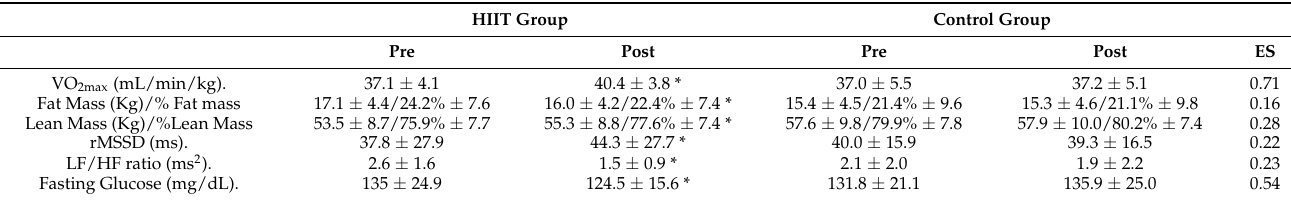
Table 1. Variables analysis before high-intensity interval training (HIIT) intervention and following training period in both groups. HIIT Group Control Group Pre Post Pre Post ES VO 2max